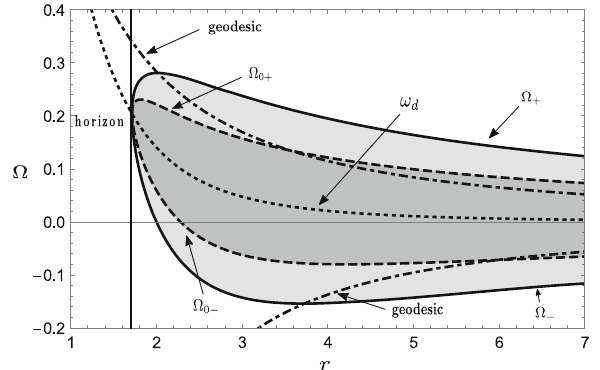
Fig. 3 Plot of (cid:18) with respect to r for M = 1 and a = 0 . 7. The solid lines (cid:18) ± represents the ultra-relativistic cases, where the Casimir energy disappear in the x -orientation. The dashed line (cid:18) 0 ± are the trajectories where the Casimir energy disappear in the y -orientation. The dotted line ω d the ZAMO trajectory and the dot-dashed line the geodesic trajectories. In the y -orientation the energy is negative in the dark gray region and positive in the bright gray region. These grays regions are all the admissible trajectories